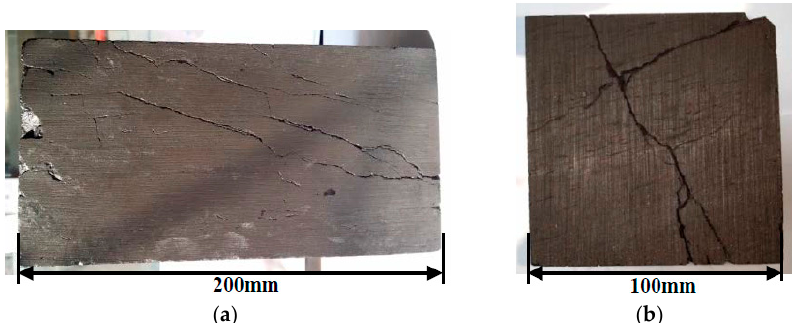
Figure 2. 100 × 100 × 200 mm coal sample for permeability tests. ( a ) Side view of the sample. ( b ) Top view of the sample.